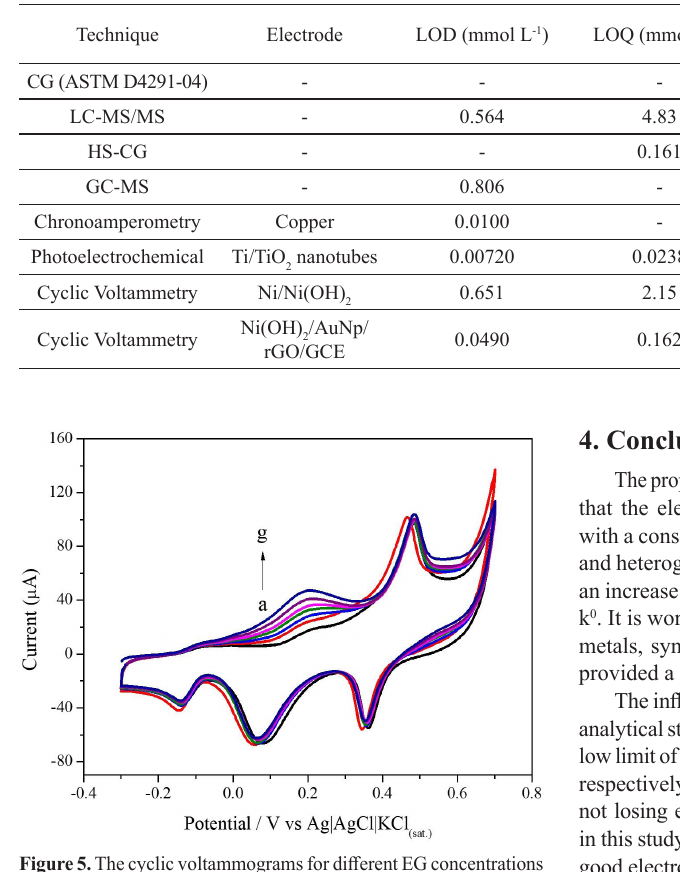
Figure 5. The cyclic voltammograms for different EG concentrations using Ni(OH) /AuNp/rGO/GCE in 0.50 mol L -1 KOH at 50 mV s -1 2 scan rate. The voltammograms are a, b, c, d, e, f and g are related to the EG concentrations at 0, 0.24, 0.48, 0.72, 0.95, 1.20 and 1.43 mmol L -1 ,